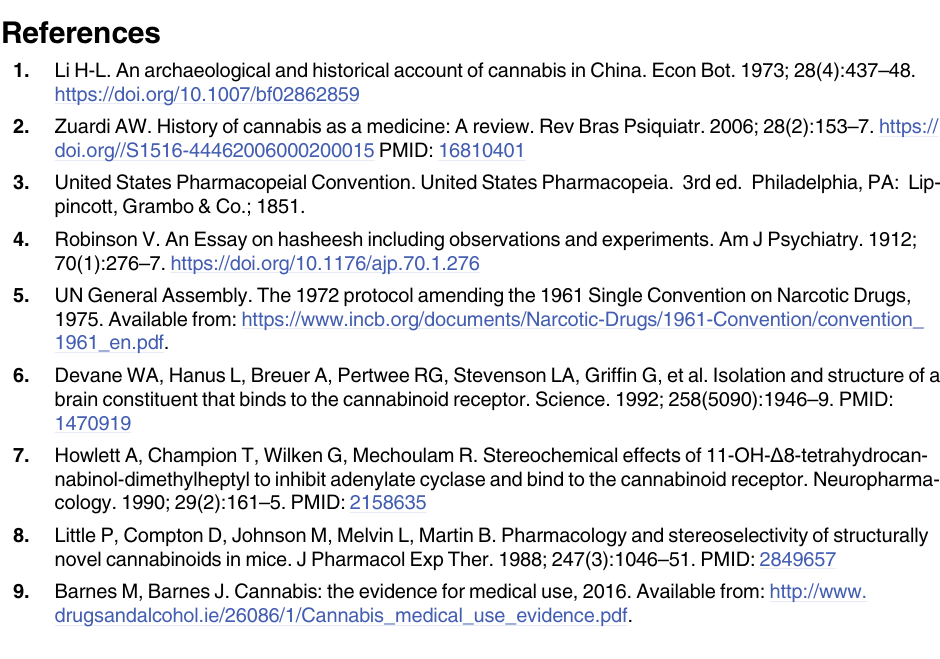
S1 Table. Database searching phrases. S2 Table. Study characteristics and summary of findings for included studies. S3 Table. PRISMA